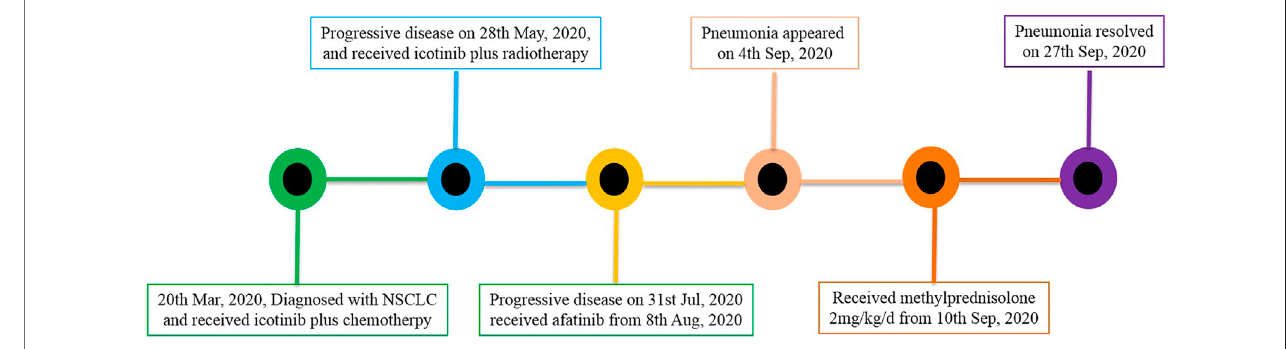
FIGURE 4 | The episodes occurred in case